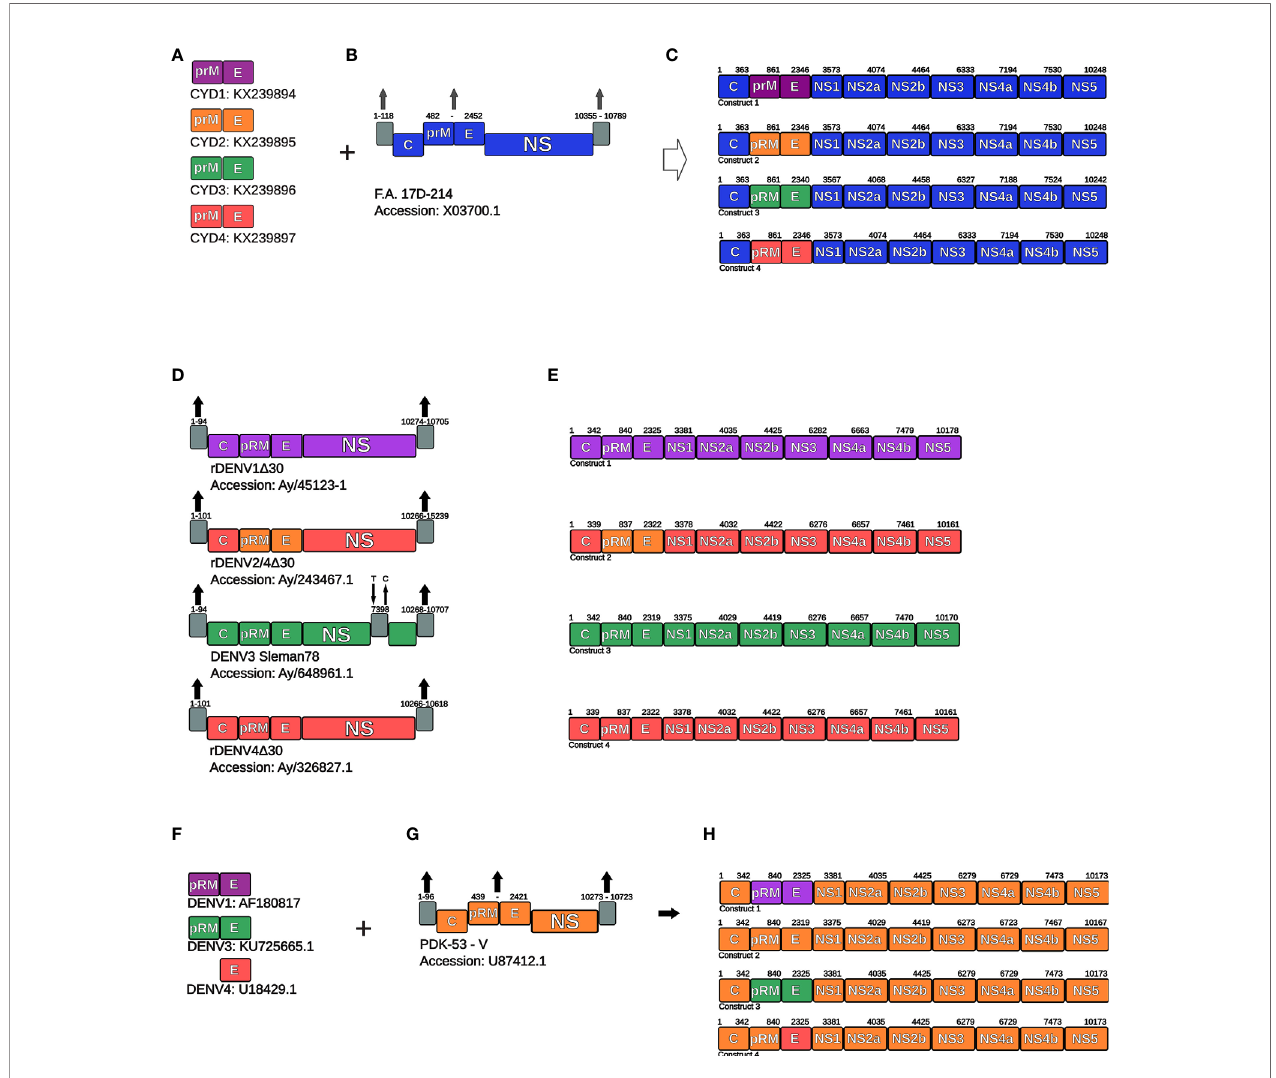
FIGURE 1 | Schematic representation of genetic constructions of vaccine antigens. (A) PrM and E coding sequences were used to chimerize Yellow fever virus (B) and generate DENGVAXIA ® vaccine antigens (chimeric viruses) (C) . (C) Schematic representation of the fi nal constructs of the DENV1-4 vaccine viruses of the DENGVAXIA ® formulation. (D) Representation of genomic characteristics of vaccine viruses of the LAV-TDV vaccine formulation (E) Schematic representation of the fi nal constructs of the DENV1-4 vaccine viruses of the LAV-TDV formulation. (F) Representation of coding sequences of PrM and E proteins of the DENV1 and DENV3, and E protein of DENV4. These sequences were used to modify PDK-53-V infectious clone (G) and generate vaccine viruses of the TAK-003 vaccine formulation (H) . Known accession numbers are shown. NS, non-structural